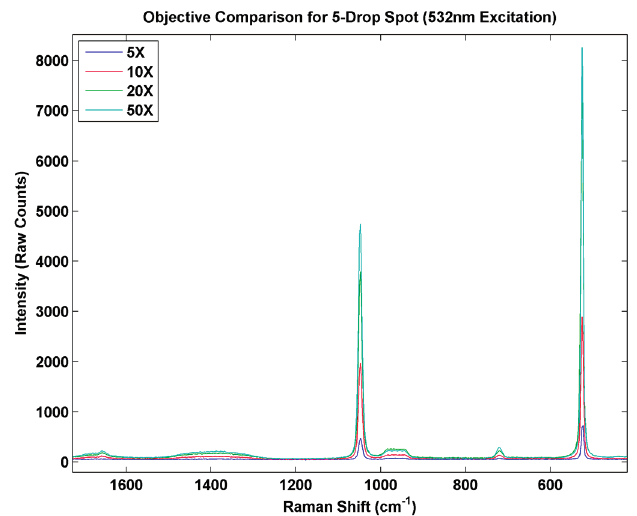
Figure 9. Micro Raman spectrum of individual AN particle prepared by inkjet printing showing the effect of microscope objective on response.